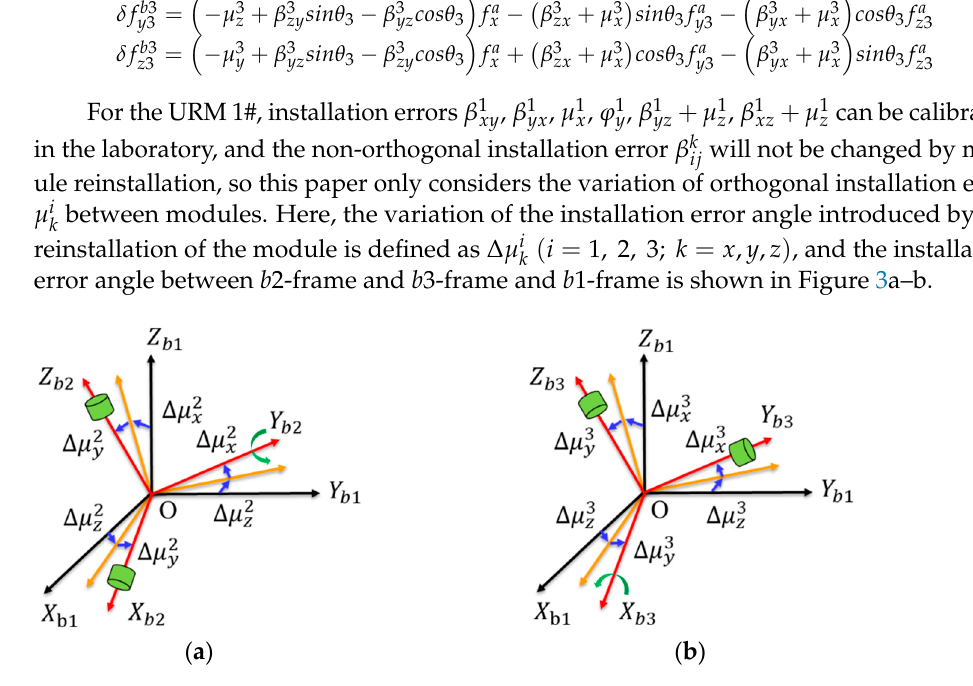
Figure 3. ( a ) The installation error of URM 2# from the b2 ‐ frame to the b1 ‐ frame; ( b ) the installation error of URM 3# from the b3 ‐ frame to the b1 ‐ frame.